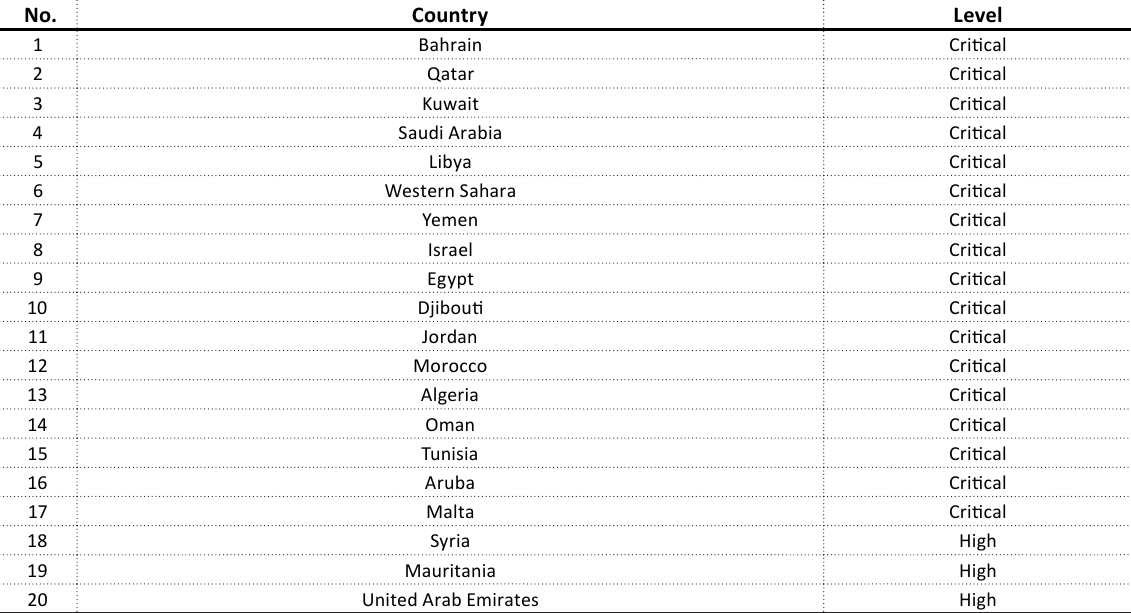
Table A1. Top 20 countries with the highest level of water resources exploitation Source: According to World Water Assessment Programme (WWAP) (2012).